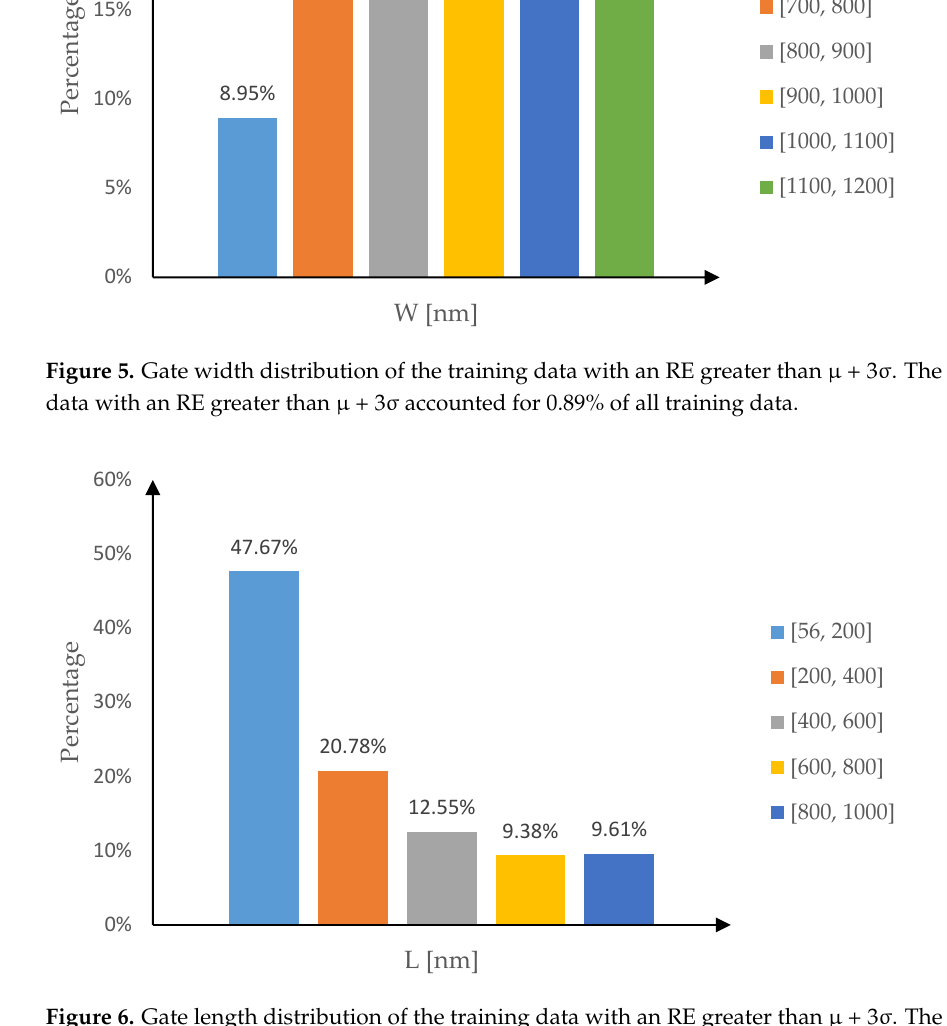
Figure 6. Gate length distribution of the training data with an RE greater than µ + 3 σ . The training data with an RE greater than μ + 3 σ accounted for 0.89% of all training data.